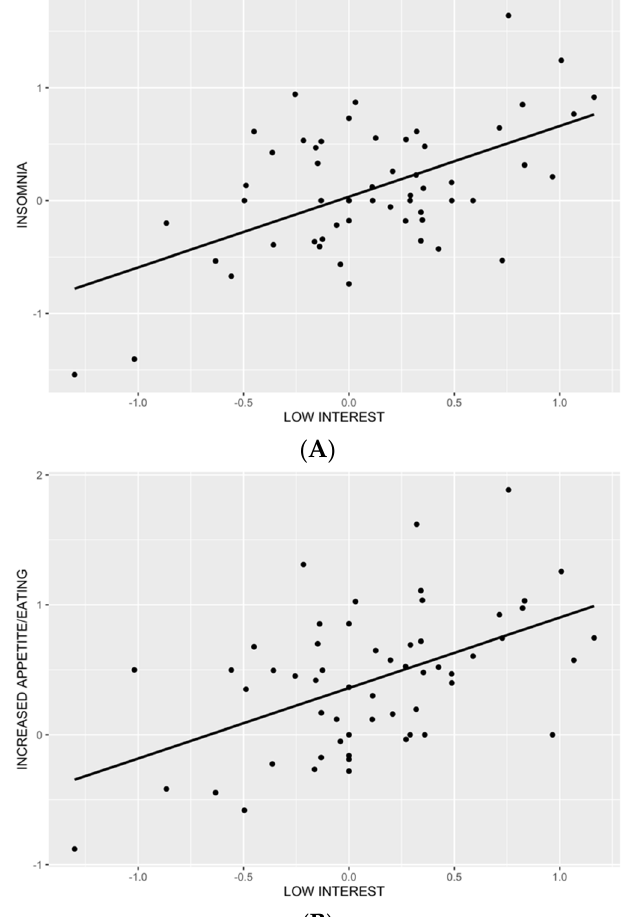
Figure 1. Scatterplot of a significant relationship between a premenstrual increase in low interest and insomnia ( p = 0.0253; ( A )), and a premenstrual increase in low interest and appetite/food intake ( p = 0.0274; ( B )).